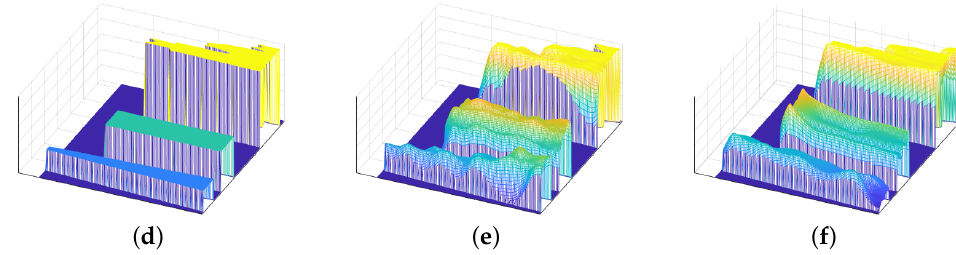
Figure 9. Estimated distance of scene 2 using a bispectral light extinction in bad weather. ( a ) RGB image. ( b ) Image at 905 nm. ( c ) Image at 980 nm. ( d ) Groundtruth. ( e ) Our result. ( f ) Result of comparison method.